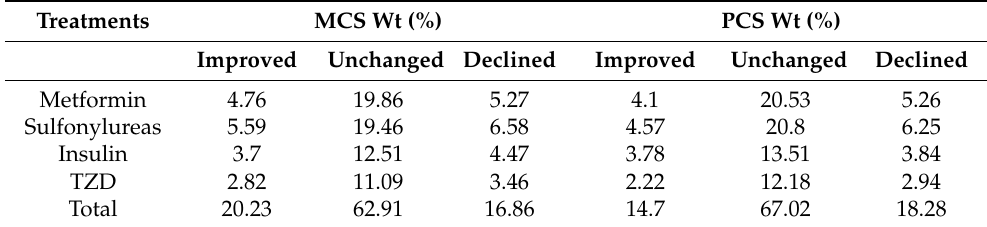
Table 2. Health-related quality of life of diabetes patients.